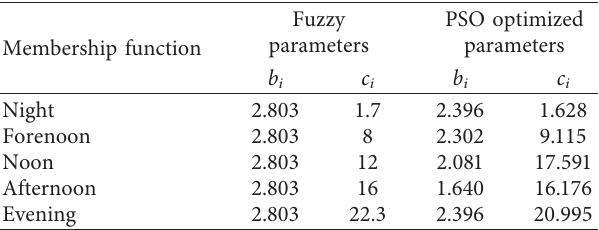
Table 3: Fuzzy-PSO optimized result of time for microgrid model.